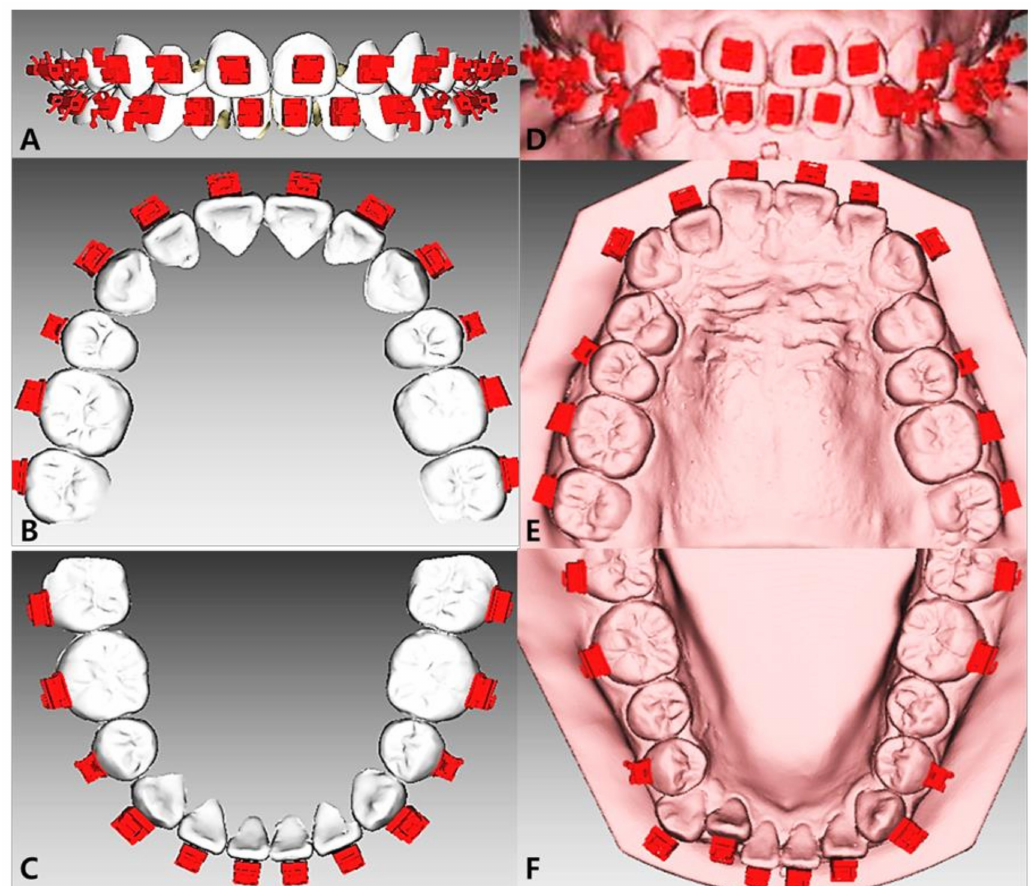
Figure 2. An example of an indirect bonding jig system (IDBS) virtual set-up procedure. ( A – C ): bracket placement on the virtual digital model; ( D – F ): bracket position on the